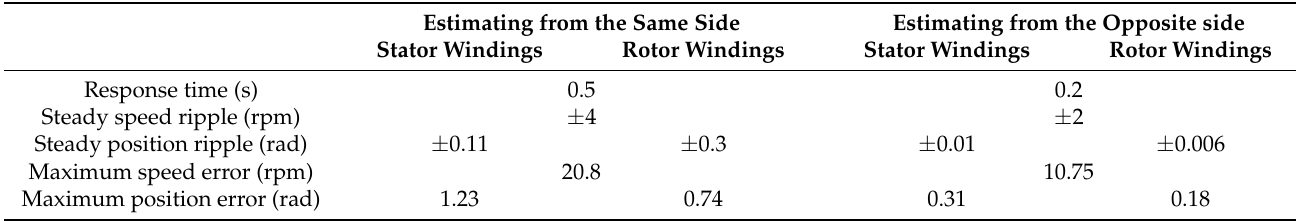
Table 3. Comparison of two estimating methods.